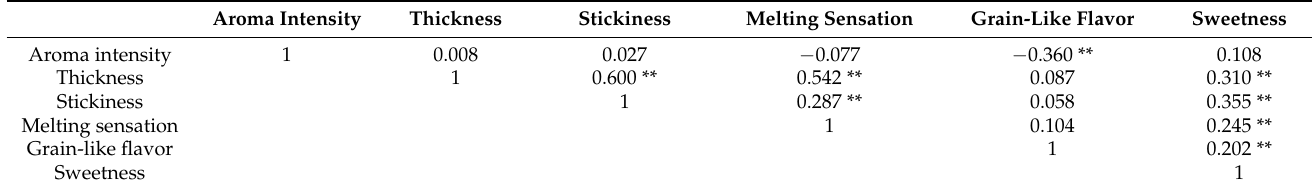
Table 4. Pearson correlations between the attributes among all the samples ( n = 40 × 5). Aroma Intensity Thickness Stickiness Melting